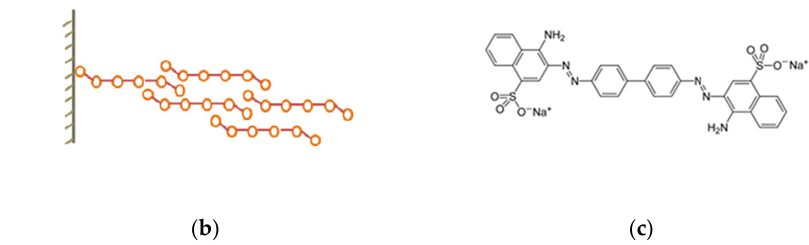
Figure 13. ( a ) Possible mechanism of electrostatic interaction of the MB molecule with the carbon shell, ( b ) mechanism of physical adsorption, and ( c ) molecule of the CR.